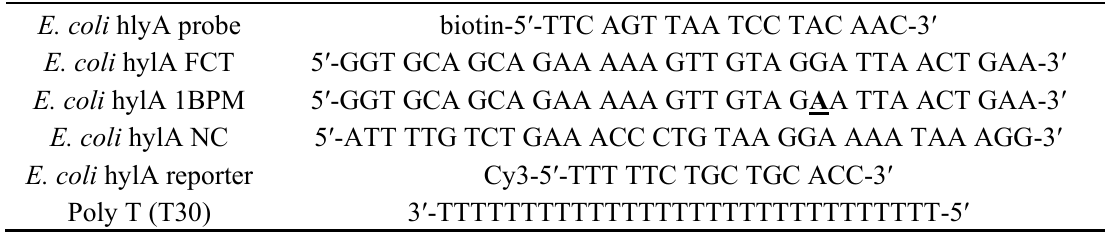
Table 1. Oligonucleotide sequences used in the hybridization assays a